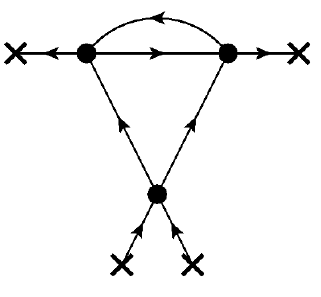
Figure 2 . The diagram corresponding to the invariant J (3 ; 2) .